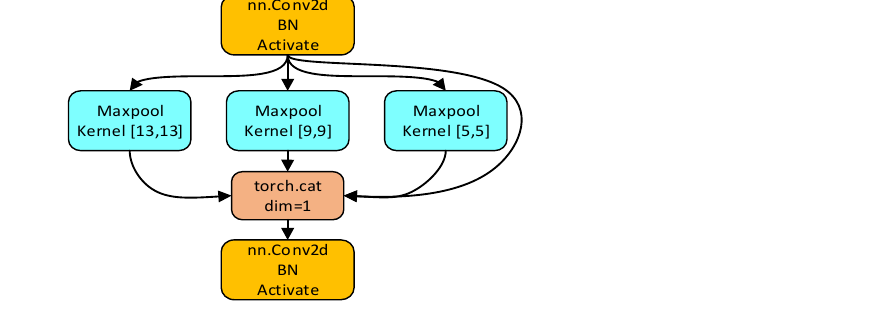
Figure 5. SPP network structure.